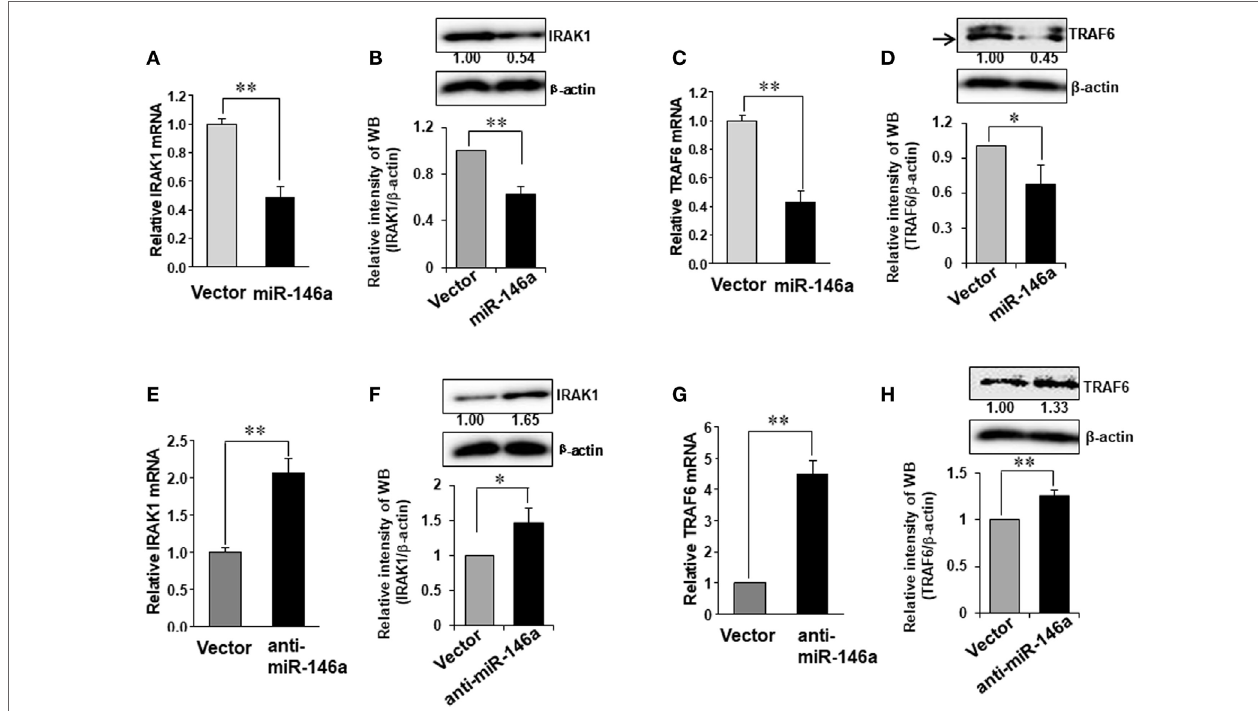
FigUre 4 | Expression of TRAF6 and IRAK1 in NK-92 cells transduced with miR-146a or anti-miR-146a. NK-92 cells expressing miR-146a or anti-miR-146a were cultured in medium without IL-2 for 24 h. Cells were harvested to extract RNA, followed by cDNA synthesis. The expression of IRAK1 (a,B,e,F) and TRAF6 (c,D,g,h) at the mRNA level and the protein level were assessed by qRT-PCR and immunoblotting, respectively ( n = 3). Data shown are mean ± SD. * p < 0.05, ** p < 0.01. Error bars represent